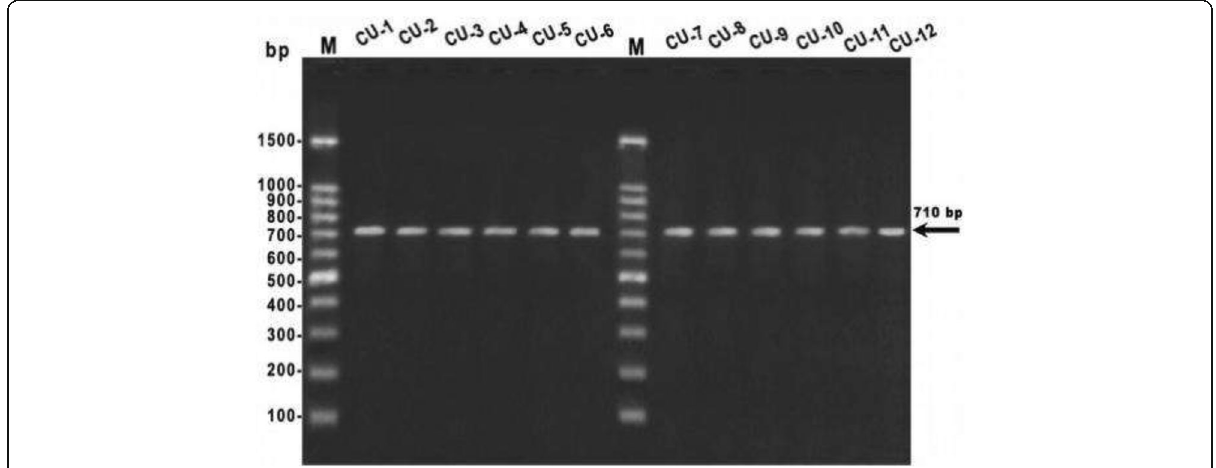
Fig. 1 Agarose gel showing polymerase chain reaction (PCR) results using DNA templates from different governorates with the primer